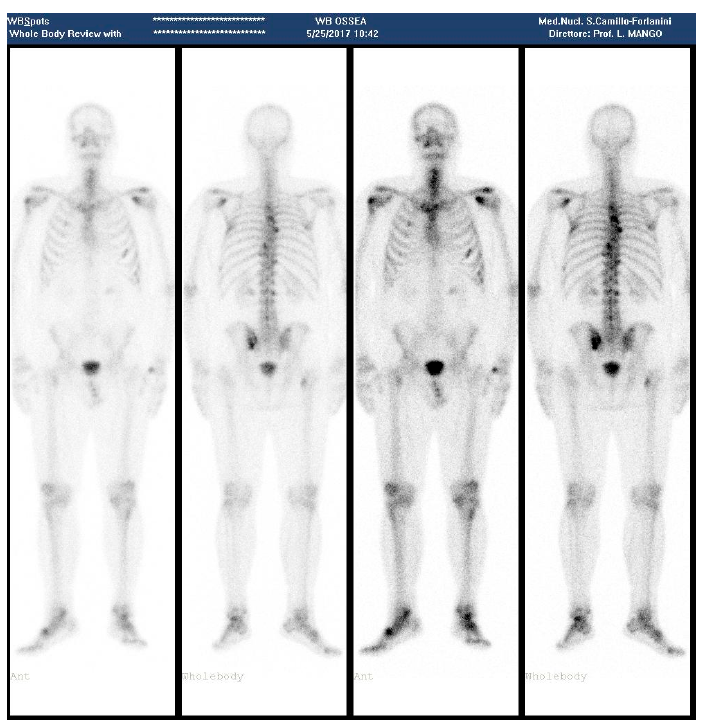
Figure 3. (May 2017—Bone scan 1 year after the last 223 RaCl 2 cycle, showing appearance of new metastatic sites).